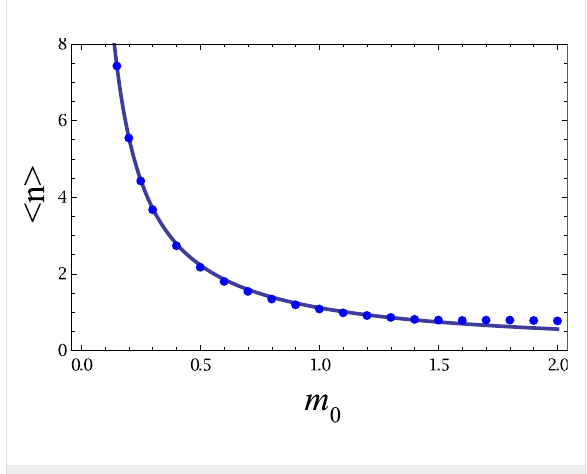
Figure 3: Mean phonon number in nonequilibrium for eV = 3 ω 0 and versus the electron–phonon coupling m 0 .